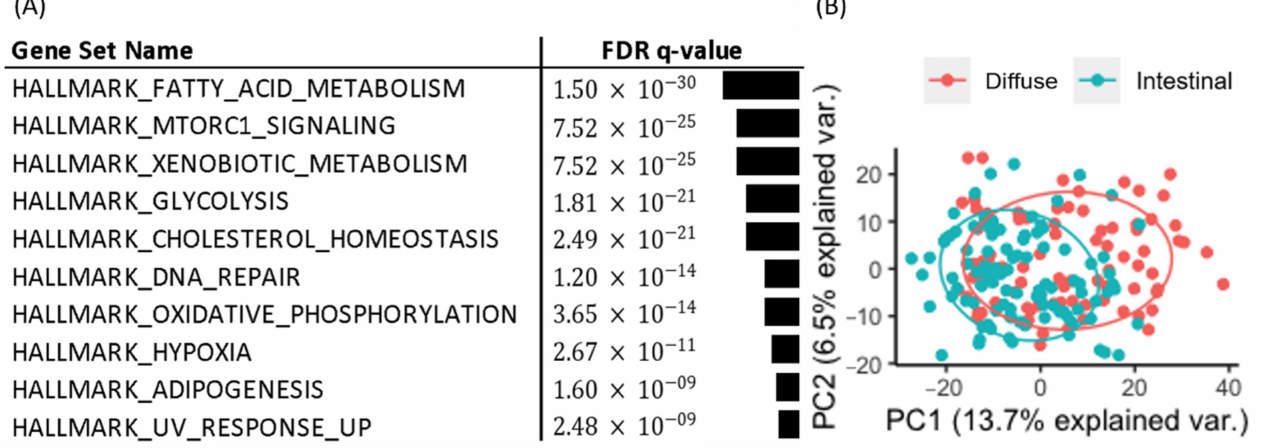
Figure 2. Hallmark gene set and PCA analysis for diffuse and intestinal GC subtypes in the TCGA. ( A ) Gene set analysis for DEGs of Lauren diffuse versus intestinal GC subtypes revealed metabolic contexts. ( B ) PCA of expression profiles of metabolism-related genes in diffuse and intestinal subtypes revealed separation between the two